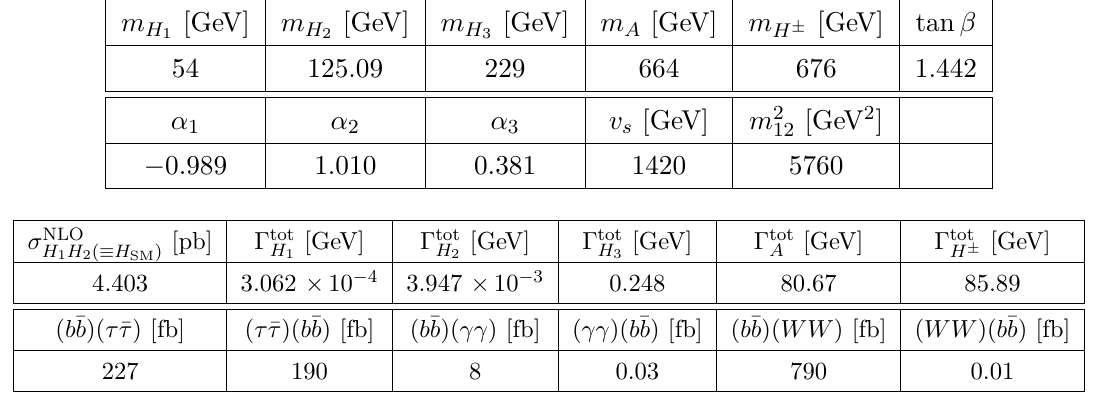
Table 25 . BP12 Upper: N2HDM-I input parameters. Lower: further information on this